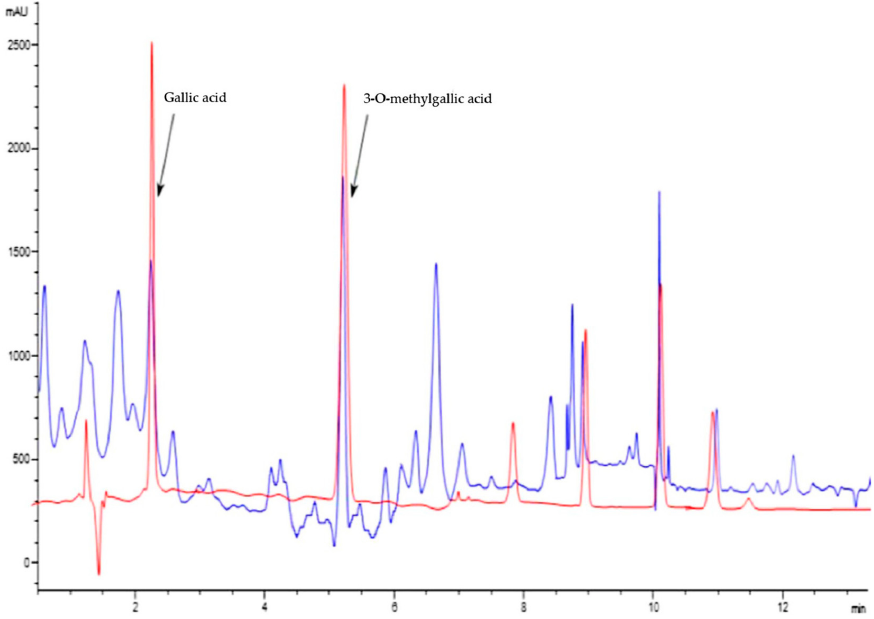
Figure 4. HPLC-DAD chromatograms using the developed method of mixed standards at 216 nm. Red line corresponds to the ethanolic solution of Lysimachia nummularia herba samples with standard solution, blue line corresponds to the ethanolic extracts without standard solution.